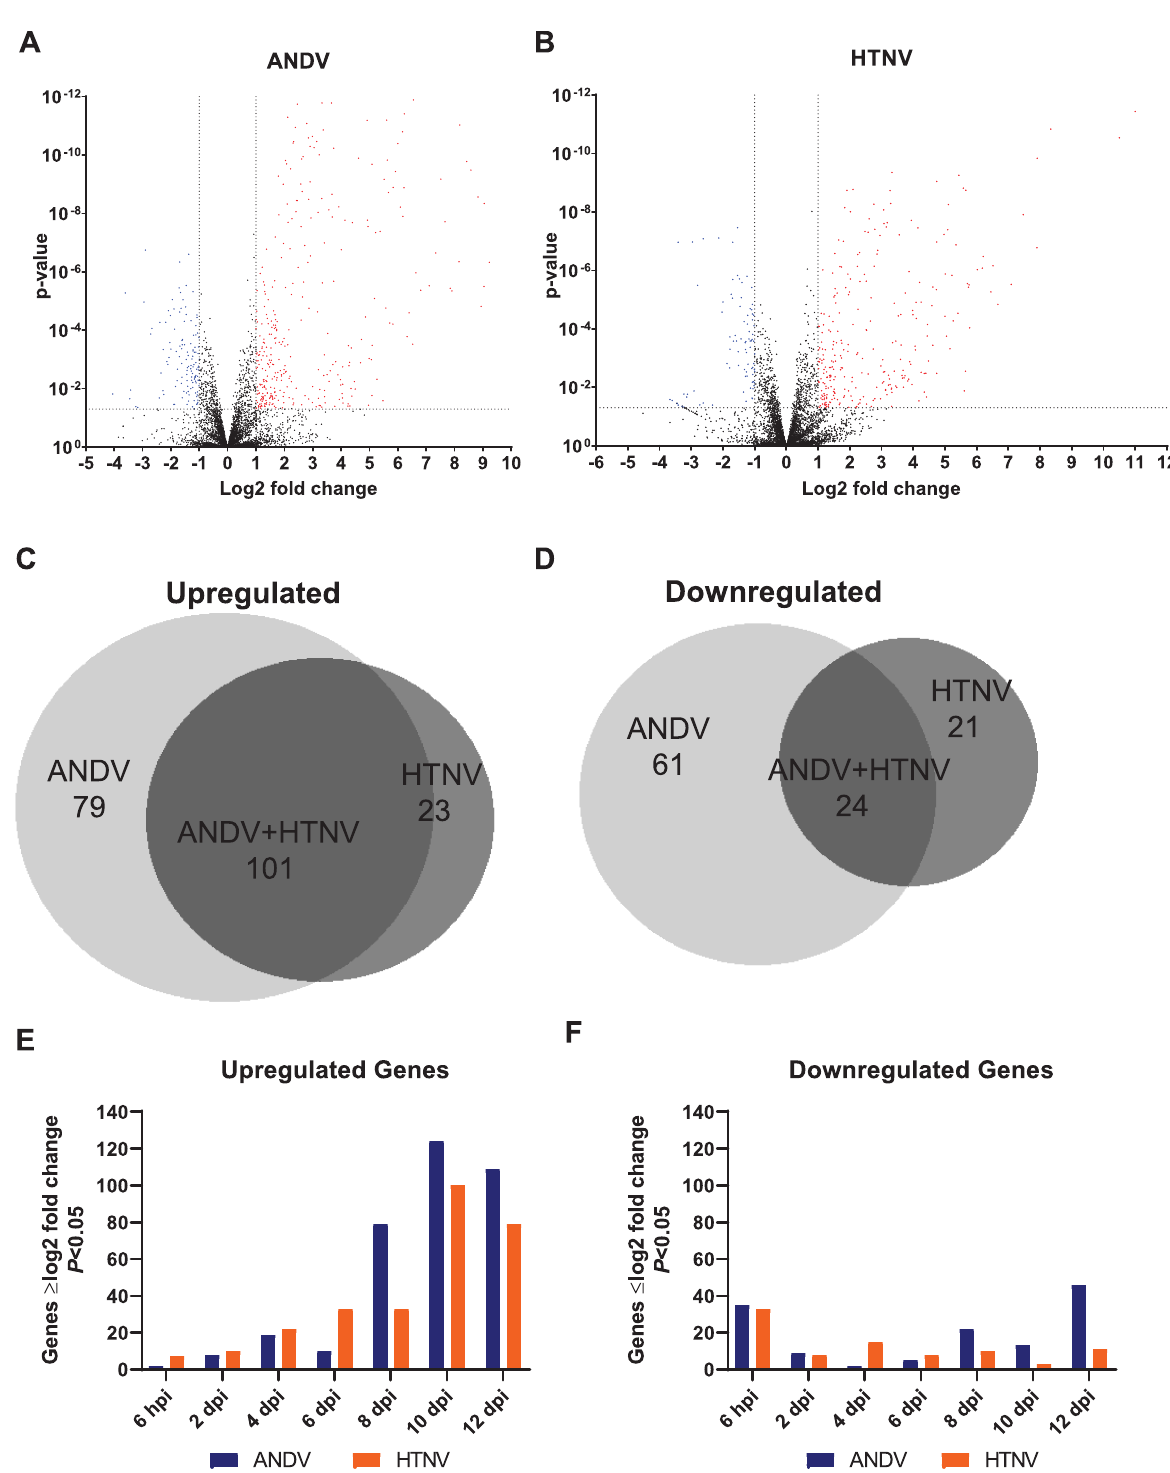
Fig 2. Overview of NanoString Gene Expression. Summary of gene expression from ANDV and HTNV time points 6 hpi, 2, 4, 6, 8, 10, and 12 dpi shown as A, B) volcano plots with significant genes that are > log2 fold change (red symbols) and < log2 fold change (blue symbols). C, D) Venn diagrams indicating significant genes upregulated and downregulated by ANDV, HTNV, and ANDV + HTNV. E, F) Upregulated and downregulated significant genes by time point.